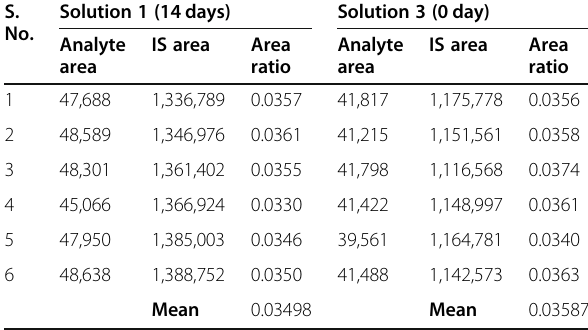
Table 17 Long-term stock solution stability for analyte LQC S. No.